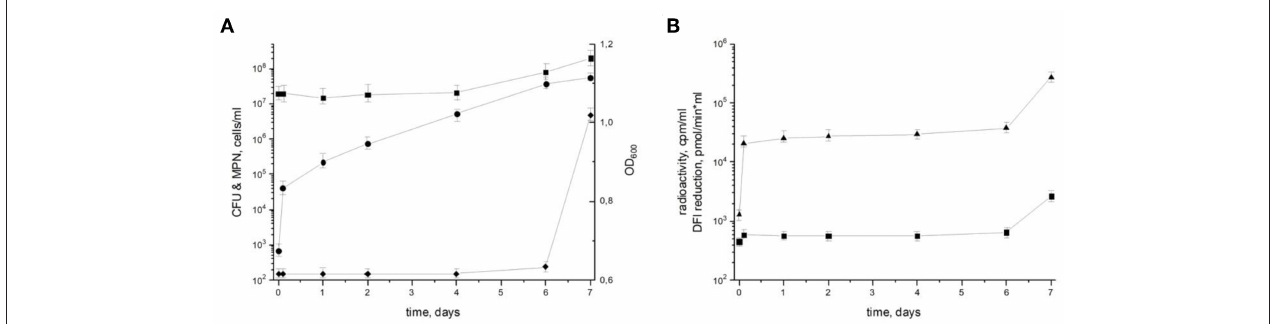
FIGURE 1 | Resuscitation of dormant non-culturable M. tuberculosis bacilli. Changes in cell characteristics during the transition from NC to actively growing state. (A) Most probable number (squares) MPN/ml; colony forming units (circles) CFU/ml; optical density (diamonds) OD 600 . (B) Radioactive incorporation of uracil (triangles) cpm/ml; DPI reduction (squares) pmol/(min × ml). This experiment was repeated five times with similar results.